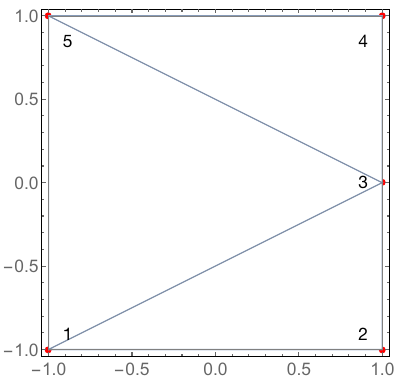
Figure 2. Adaptive reference element A : Quadrilateral with five nodes. Minimal implementation mesh with three triangles. The element mapping is defined using the four corner nodes